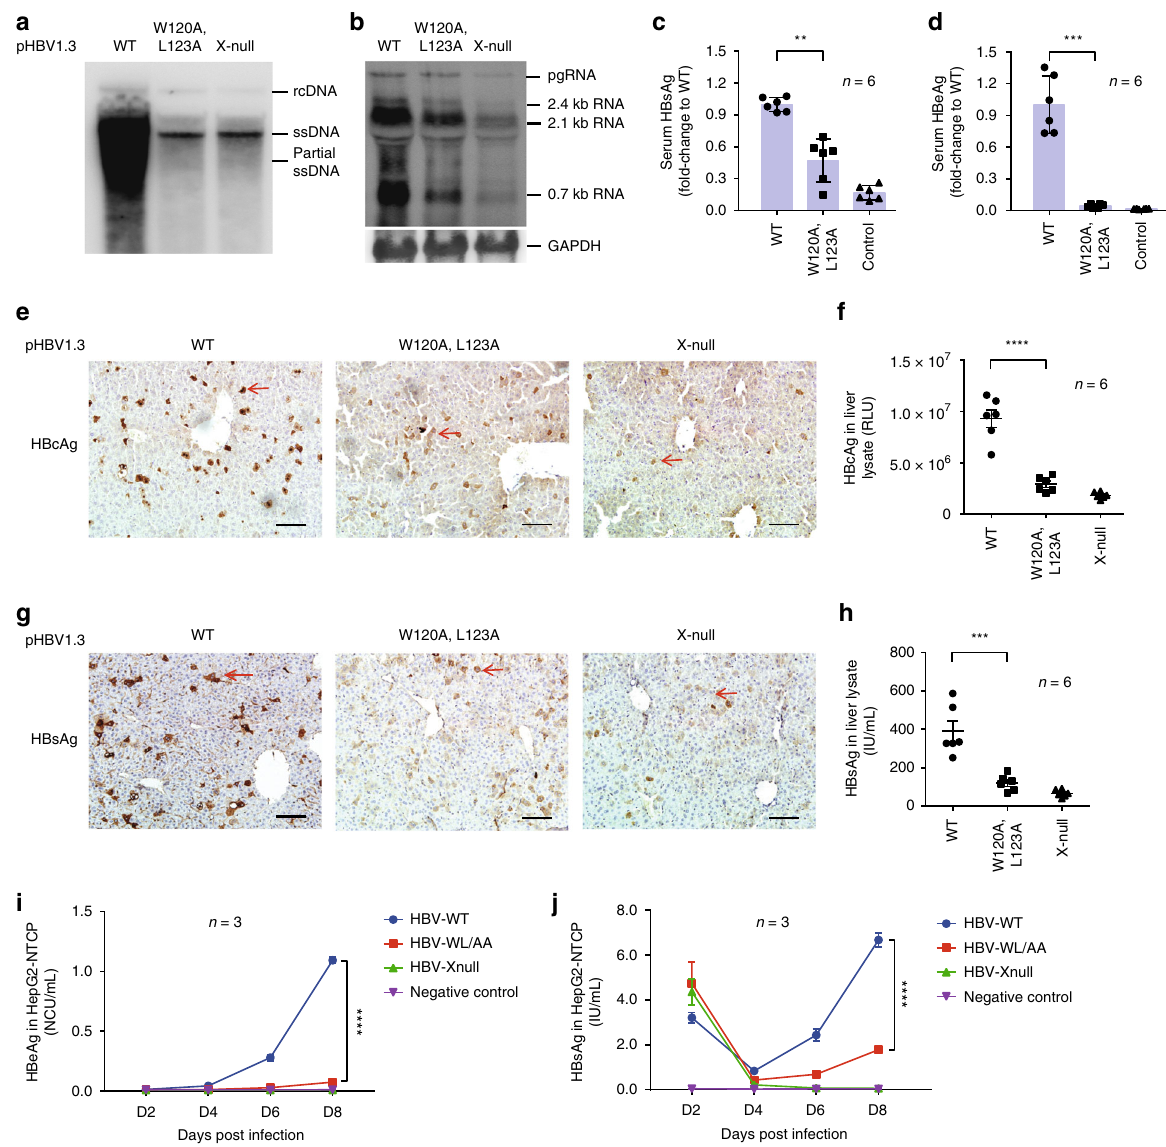
Fig. 4 HBx Trp120 and Leu123 residues are critical for HBV production in mice and HepG2-NTCP cell. a , b Southern blot analysis of HBV DNA replication ( a ) and Northern blot analysis of HBV transcription ( b ) in HepG2 cells transfected with pHBV1.3-WT (wild type), pHBV1.3-HBx(W120A/L123A), or pHBV1.3-HBx-null, respectively. c – h Analysis of HBV viral protein expression in a HBV mouse model. Expression levels of serum HBV S-antigen (HBsAg) ( c ) and HBV e-antigen (HBeAg) ( d ) and expression levels of intrahepatic HBV core antigen (HBcAg) ( f ) and HBsAg ( h ) in liver lysates from mice 3 days post hydrodynamic injection of the pHBV1.3-WT replicon, the pHBV1.3-HBx(WL/AA) replicon, or the pHBV1.3-HBx-null replicon were analyzed by chemiluminescent enzyme immunoassay (CLEIA), respectively. The expression levels of intrahepatic HBcAg ( e ) and HBsAg ( g ) in the liver tissue sections from these mice were also examined by immunostaining. Scale bar is 100 μ m. The red arrows indicate the hepatic cells with HBcAg or HBsAg expression. pcDNA3.1-EGFP was co-injected with the HBV replicon as an injection marker to normalize the transfection ef fi ciency ( n = 6 biologically independent animals). i Kinetics of HBeAg and j HBsAg levels post HBV-WT (blue line), HBV-WL/AA (red line), and HBV-Xnull (green line) infection in HepG2-NTCP cell line, supernatant of untreated HepG2-NTCP cell was used as a negative control (purple line) ( n = 3 biologically independent samples). The data represent mean ± SD. Signi fi cant differences between groups are indicated on the top. ** P < 0.01, *** P < 0.001, **** P < 0.0001; two-tailed unpaired t -tests. Source data are provided as a Source Data fi le